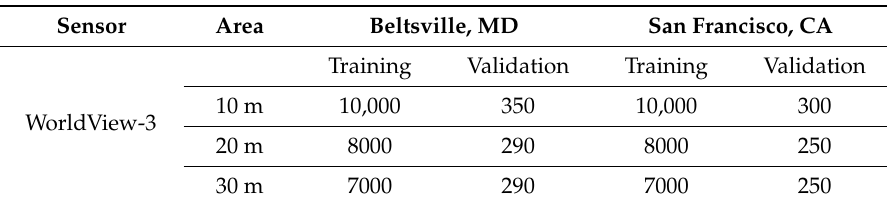
Table 2. Numbers of training and validation